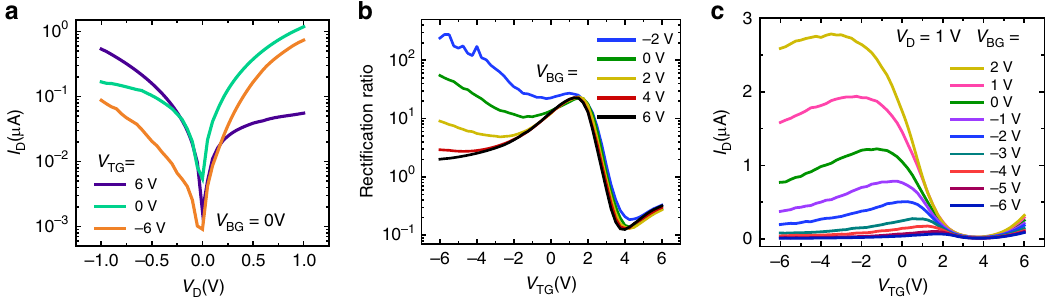
Fig. 2 Independent gate operation of Gaussian heterojunctions transistors. a Representative I D – V D curves for V BG = 0 V, illustrating the V TG tunability of the rectifying diode response, including inverted polarity of the recti fi cation direction (orange versus purple). b Recti fi cation ratios ( I D at V D = 1 V divided by I D at V D = – 1 V) of the diode for various biasing conditions, showing tunability by both V TG and V BG. c I D - V TG for different values of V BG , exhibiting tunability of the peak position of the antiambipolar response. All measurements were performed in ambient at room temperature with V S = 0 V.